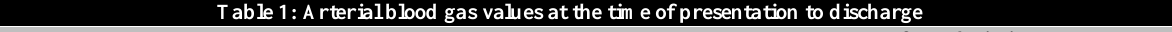
Table 1: Arterial blood gas values at the time of presentation to discharge Variables Normal Range